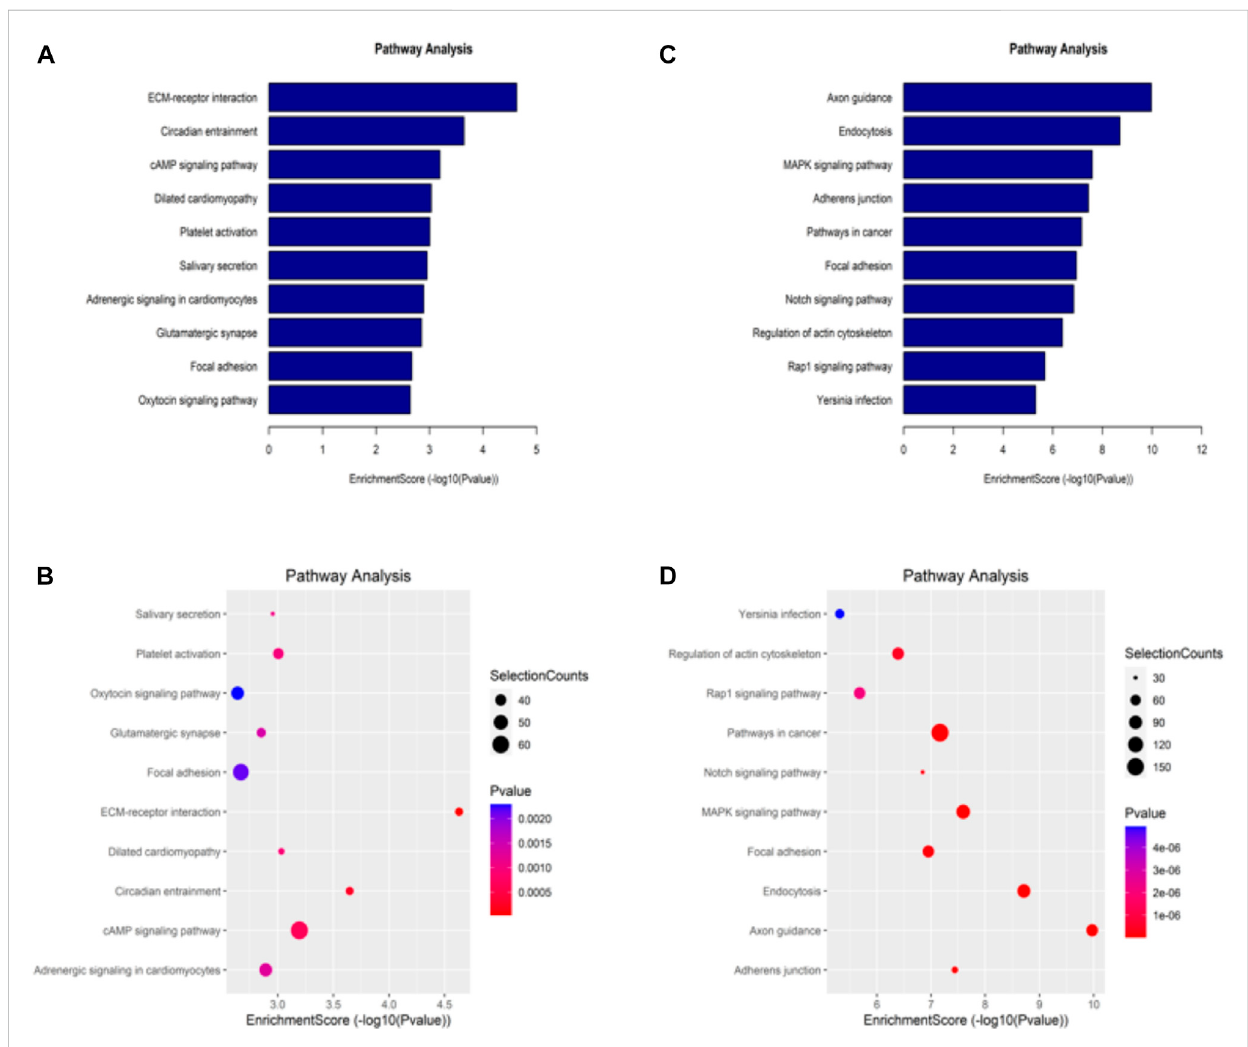
FIGURE 5 KyotoEncyclopediaofGenesandGenomesanalysisofdifferentiallymethylatedgenesinHCT15andshNSUN2-HCT15cell (A,B) Pathwayanalysisof up-methylated genes in sh-NSUN2 HCT15 cell group. (C,D) Pathway analysis of down-methylated genes in sh-NSUN2 HCT15 cell